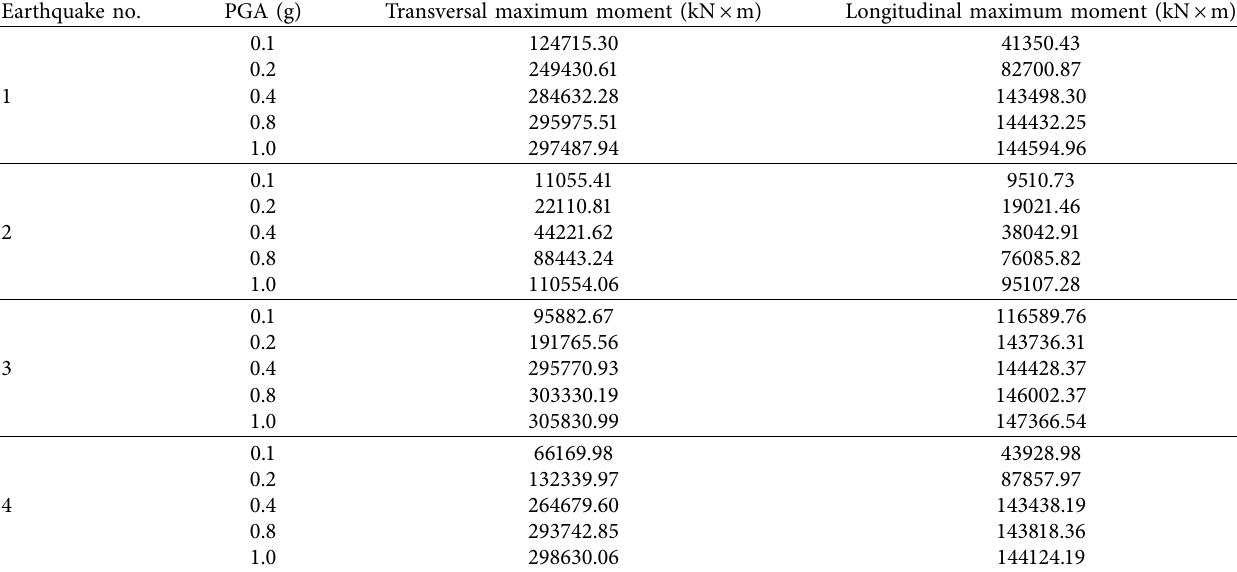
Table 5: IDA results of the middle pier bottom (bridge completion stage). Earthquake